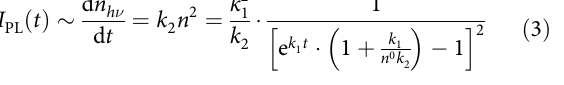
Fig. 4c. The integrated current density derived from the